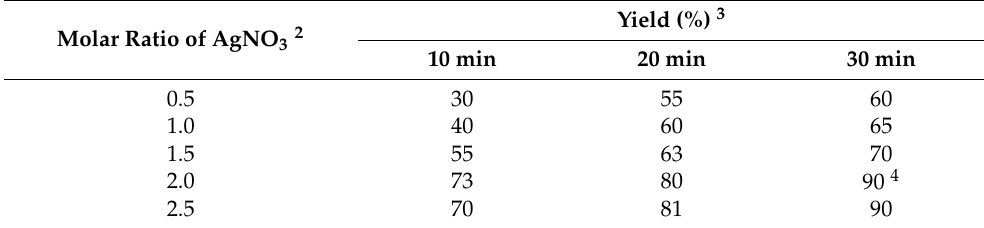
Table 2. Optimization of the iodination of cytosine at room temperature 1